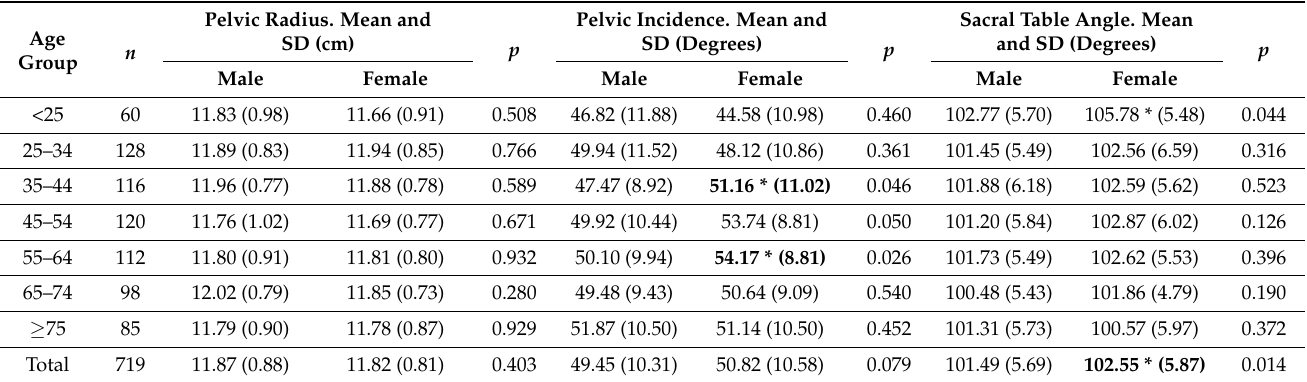
Table 1. Anatomical measurements per age group. Measurements are given as means and standard deviations (SD). Significantly larger values compared to opposite sex are printed bold and marked with an asterisk (*); p -values were derived from t